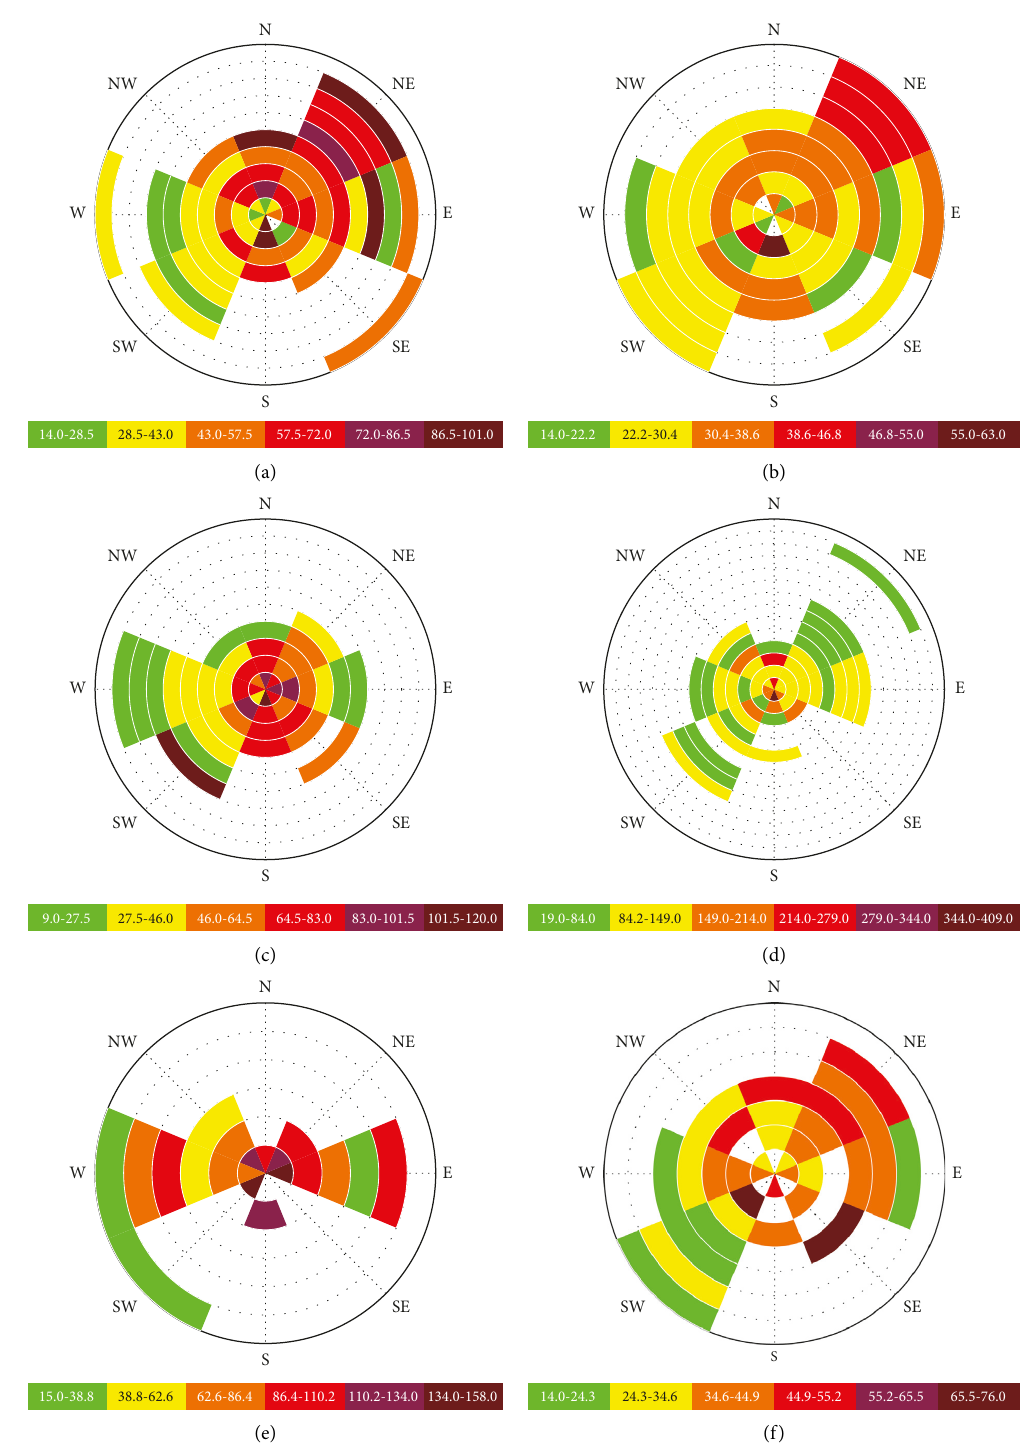
Figure 5: PM 2.5 pollution roses for spring, summer, autumn, and winter 2016–2019 and PM 2.5 pollution roses for January-February